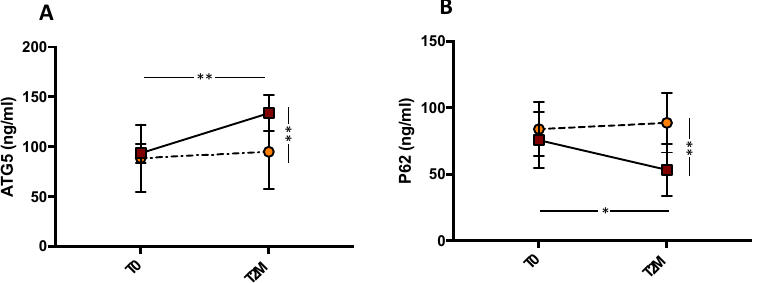
Figure 3. Serum ATG5 ( A ) and P62 ( B ) before (T0) and 2 months (T2M) after mixture intake ( n = 10) or no treatment ( n = 10) in peripheral artery disease patients. Data are expressed as mean ± SD. * p < 0.05, ** p < 0.01.